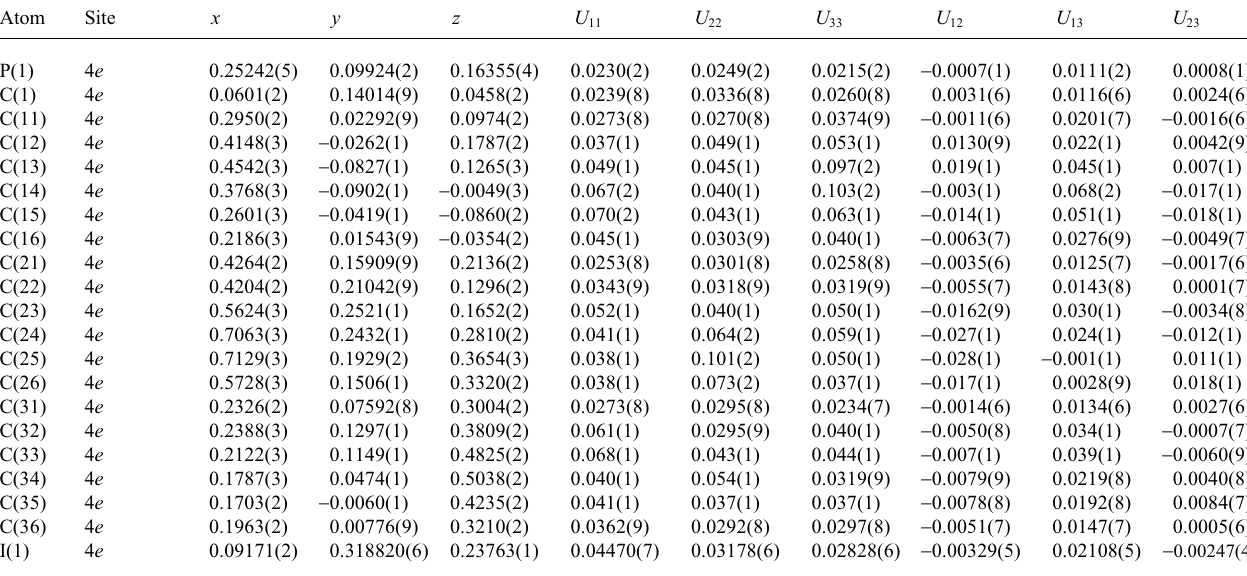
Table 3. Atomic coordinates and displacement parameters (in Å 2 )